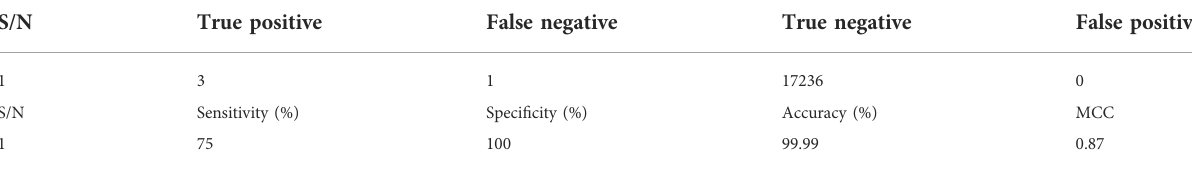
TABLE 3 Independent testing of the pro fi